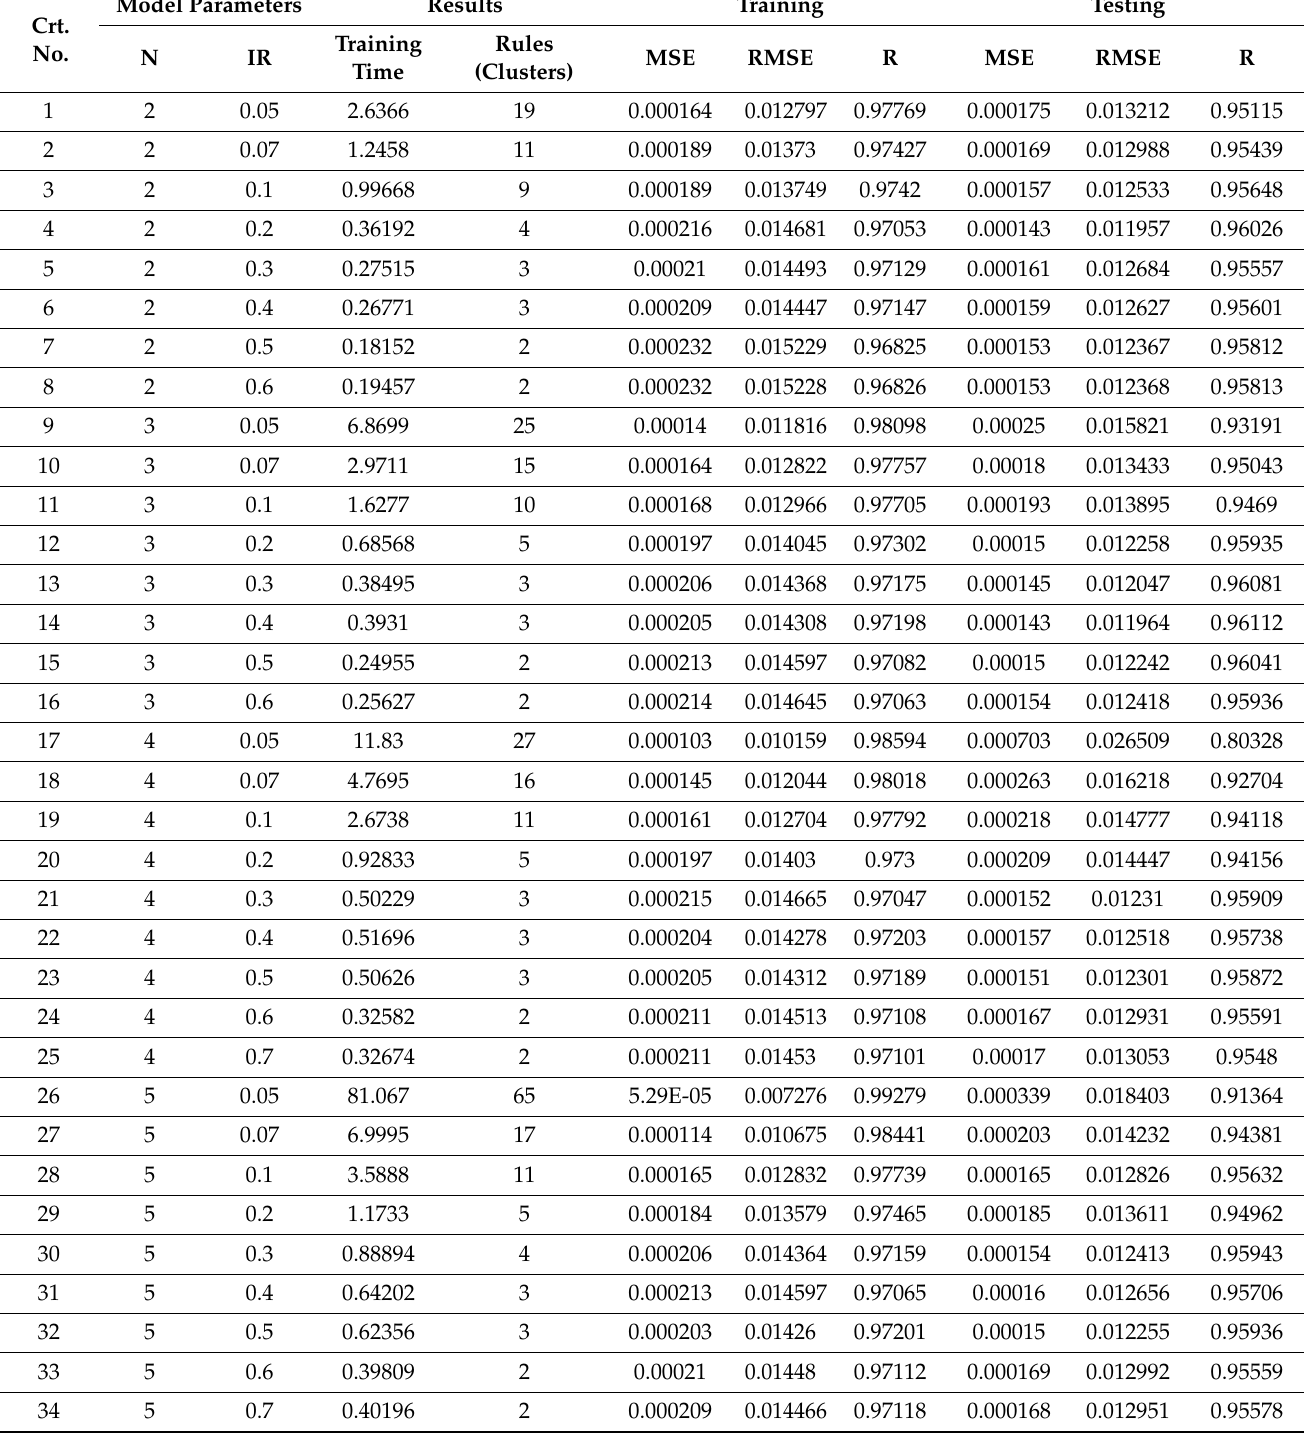
Table 2. Results of modelling and prediction using ANFIS subtractive clustering.